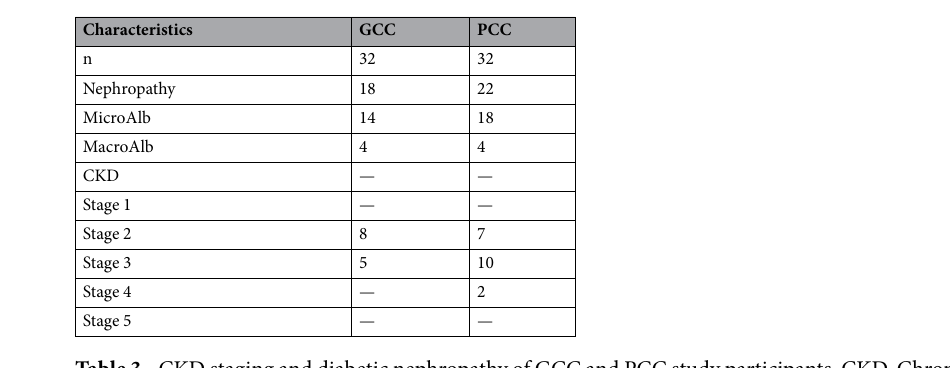
Table 3. CKD staging and diabetic nephropathy of GCC and PCC study participants. CKD, Chronic Kidney Disease, MicroAlb, Microalbuminuria, MacroAlb,